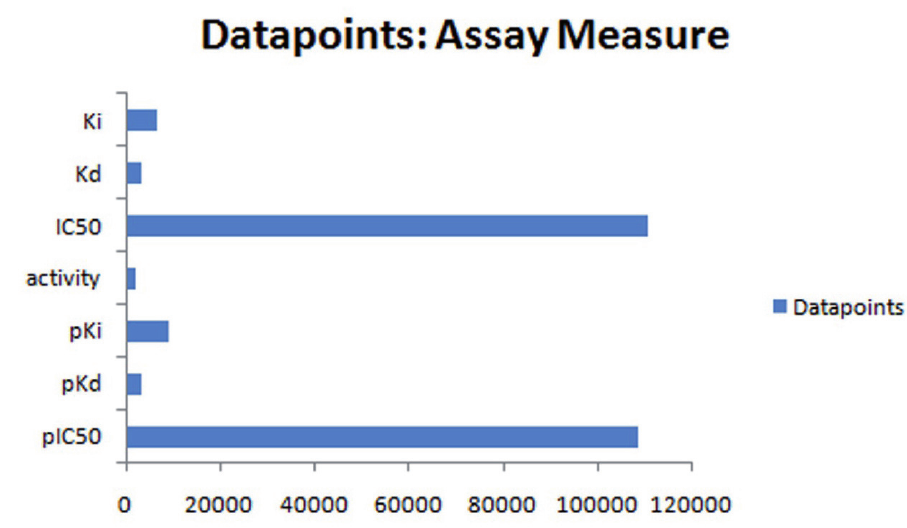
Figure 3. Data points in various assay measures.